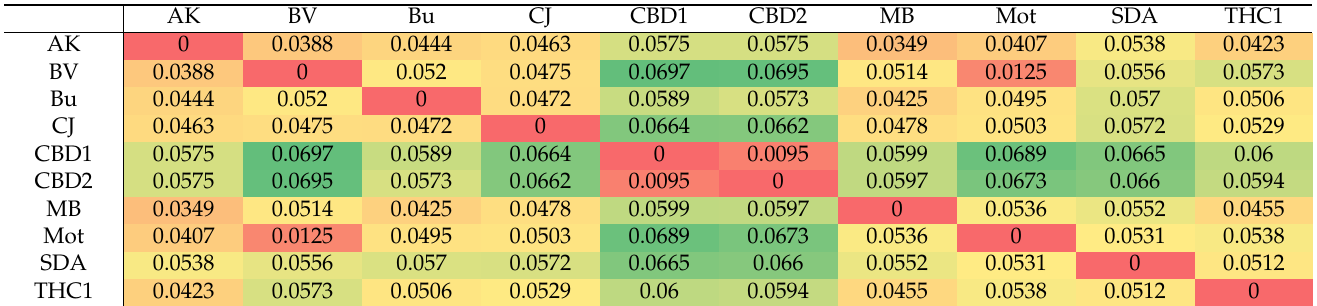
Table 1. Analysis of Nei’s genetic difference across 10 Cannabis varieties. Green indicates a greater genetic difference to the compared variety, while red indicates a reduced